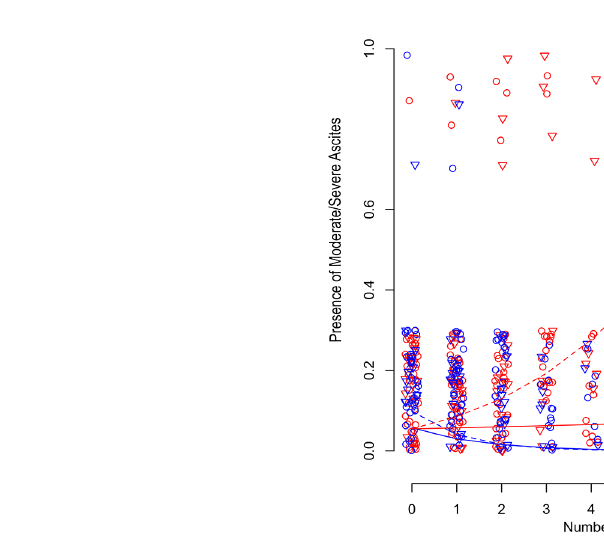
FIGURE 3 | Scatter plot illustrating longitudinal changes over time in the development of moderate/severe ascites according to the number of TACEs and strati fi ed by Child-Pugh (CP) stability (line = stable, dotted line = unstable) and metastatic (MET)/HCC groups. Each small shape ( D or O) represents a patient ’ s presence at a TACE. Shapes are jittered for visualization purposes to avoid cluttering on top of each other. The linear time model in the log(Probability)/(1-log(Probability)) scale shows as a curve (nonlinear) model in the Probability scale.